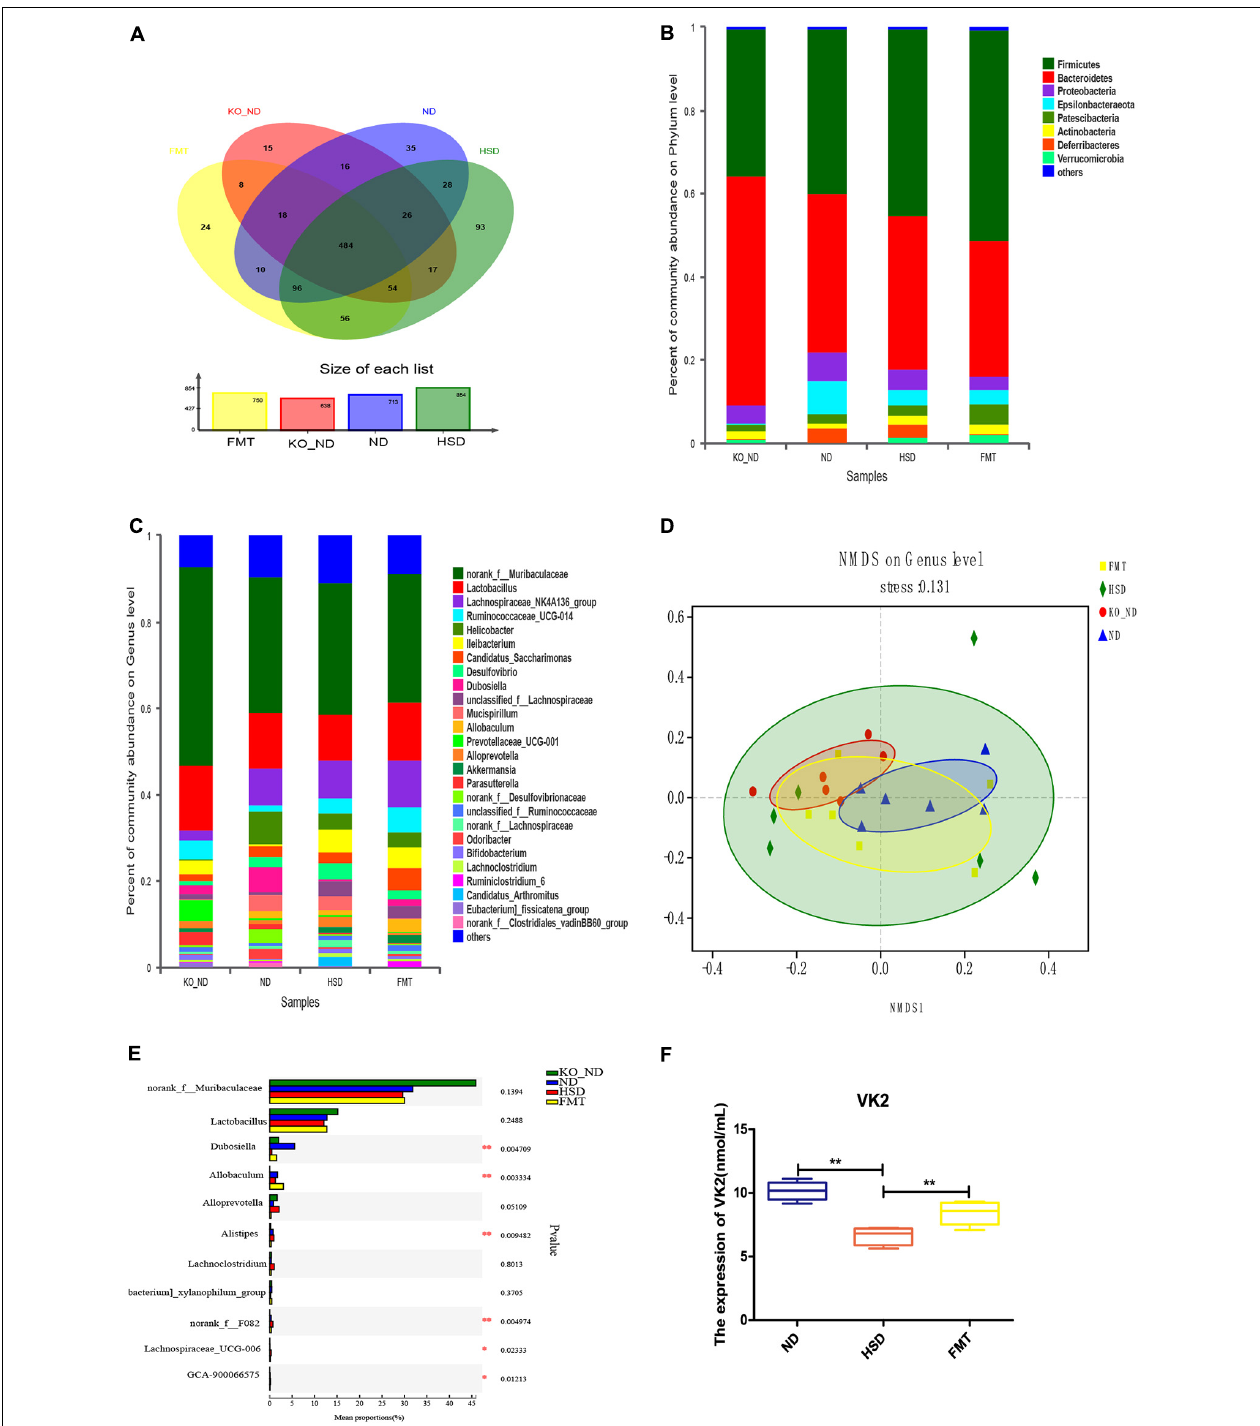
FIGURE 6 | FMT using Atf4 ± mice fecal microbiota altered the composition of gut microbiota and expression of the microbial metabolite VK2 in high-salt-induced hypertensive mice. (A) Venn diagram of OTUs. Different colors represent different groups. (B) Relative abundance plots displaying the differences in the microbial community structure at the phylum level. (C) Relative abundance plots displaying the differences in the general microbial community structure. (D) NMDS plots were used to visualize differences in weighted UniFrac distances at the genus level of samples from different groups. (E) The 11 taxonomic groups associated with FMT. * p < 0.05 and ** p < 0.01. (F) FMT upregulated the expression of VK2. Data are presented as mean ± SD; ** p < 0.01, n = 6–8; statistical comparisons were performed using Student t -test or one-way analysis of variance (ANOVA). FMT, fecal microbiota transplantation; VK2, vitamin K 2 ; KO-ND, Atf4 ± mice with natural diet; ND, WT mice with natural diet; HSD, WT mice with high-salt diet.